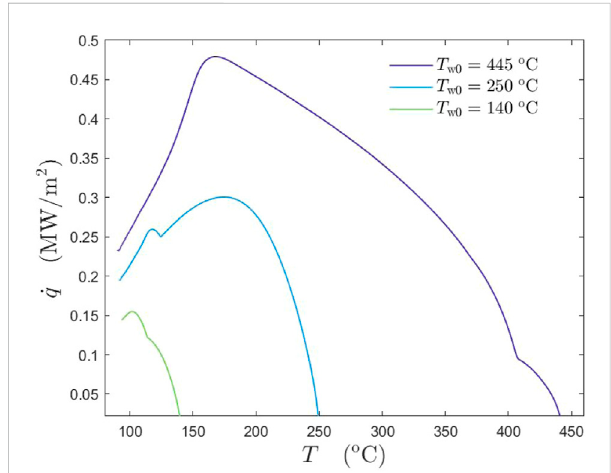
FIGURE 6 Comparison of the boiling curves of a lubricant solution φ = 1.49% for different initial substrate temperatures: T w0 = 140 ° C, T w0 = 250 ° C and T w0 = 445 ° C. The spray parameters are: The mean drop